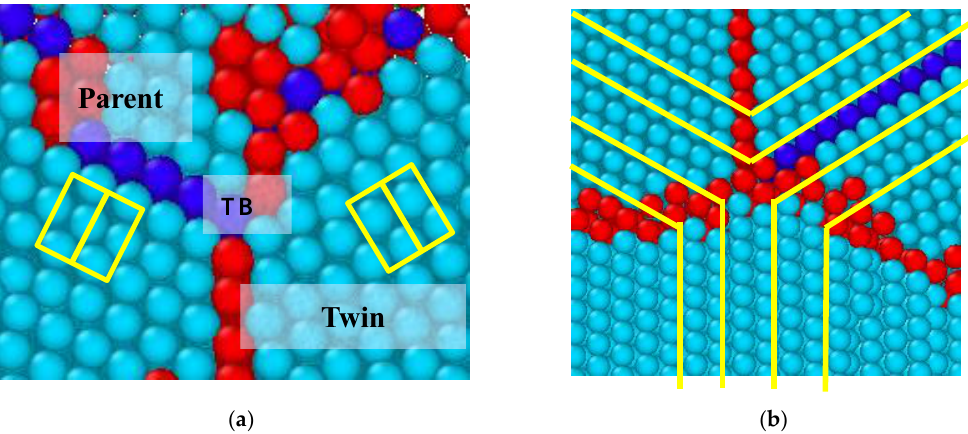
Figure 8. ( a ) TB between the parent lattice and the twined lattice; ( b ) the structure of { 1011 }(cid:104) 1012 (cid:105) twin.